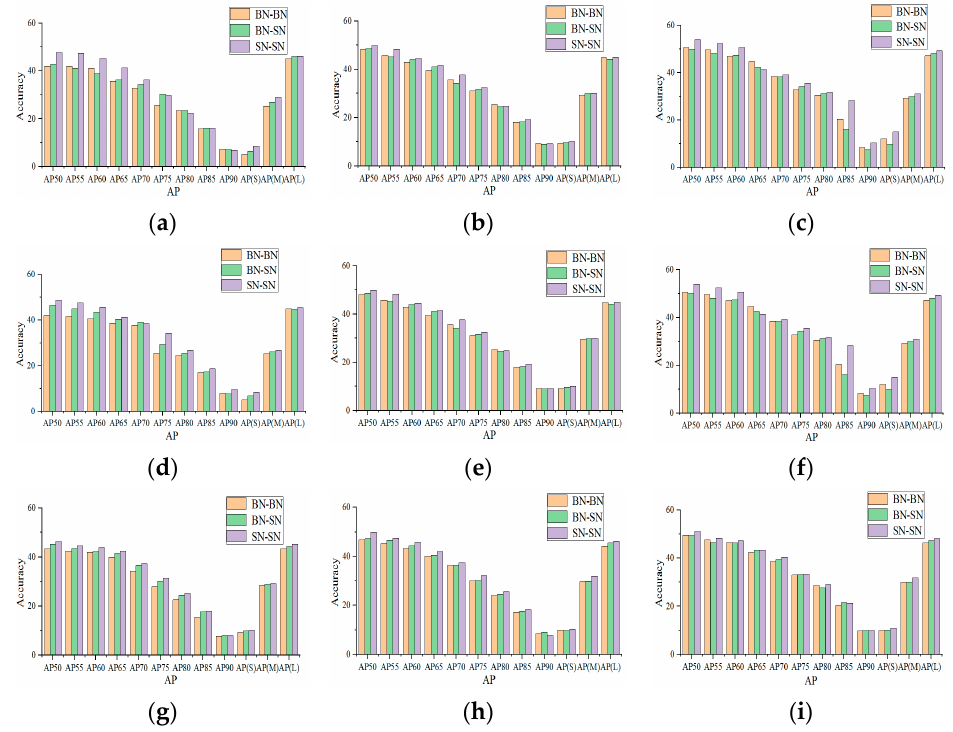
Figure 2. Average segmentation accuracy of three networks with different normalization methods.